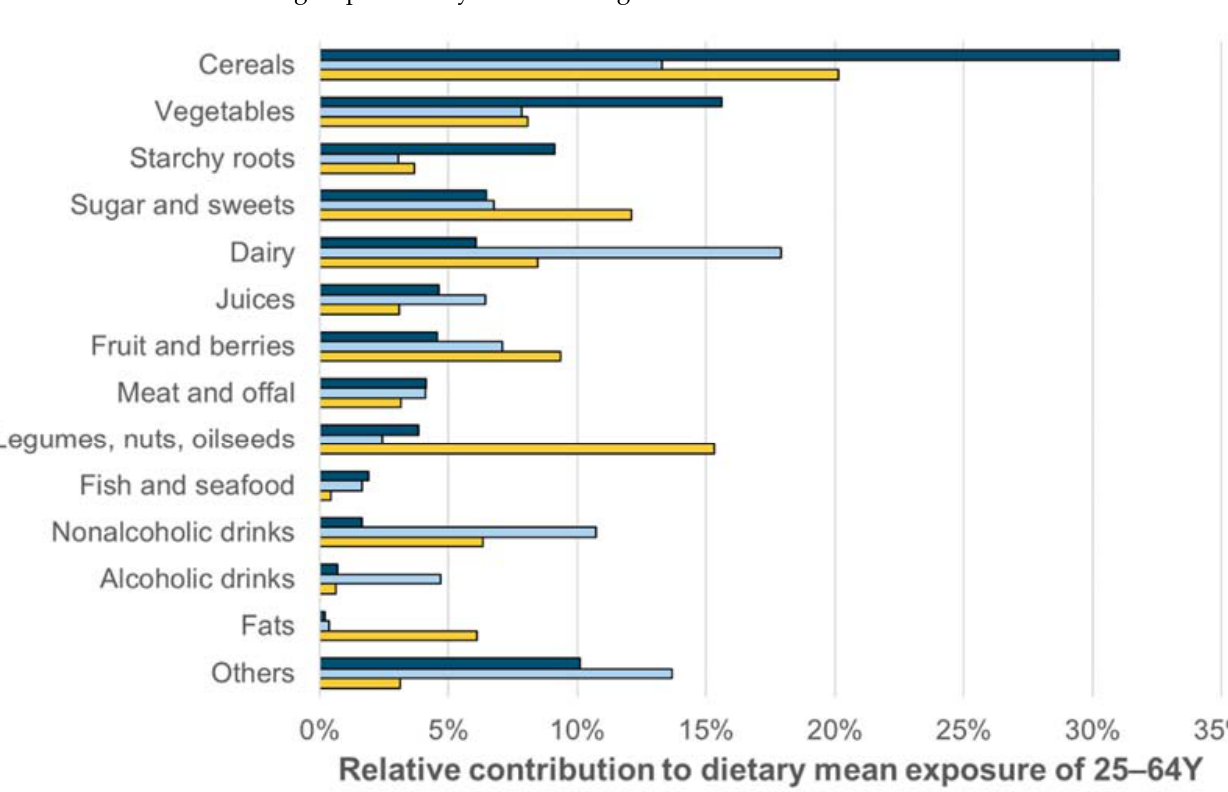
Figure 1. Relative contributions of different food groups to cadmium, lead and nickel exposure of the average consumer of 25 to 64 years, according to FinDiet 2012 consumption data. Food groups are shown in the order of importance for cadmium. The group “Others” in this figure includes eggs, spices and condiments, drinking water, weight loss products (low-cal foods, bars etc.), supplements and combination foods, i.e., dishes that were not divided into ingredient level in the consumption data.